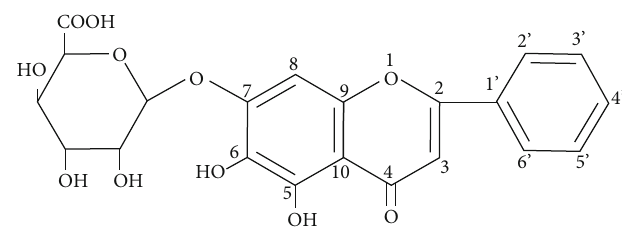
Figure 1: The structure of